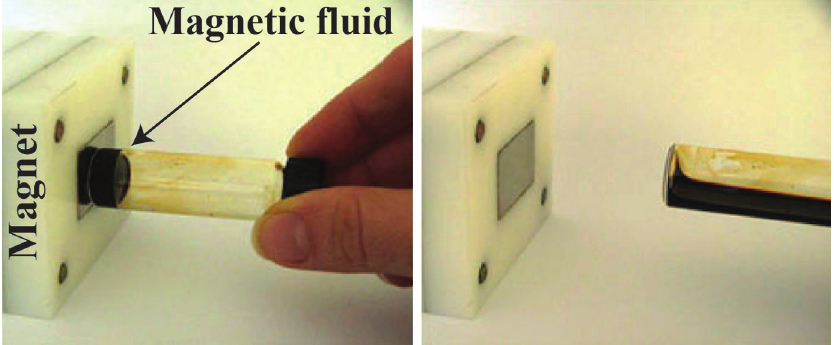
O NPs in the presence and absence of an applied magnetic 3 4